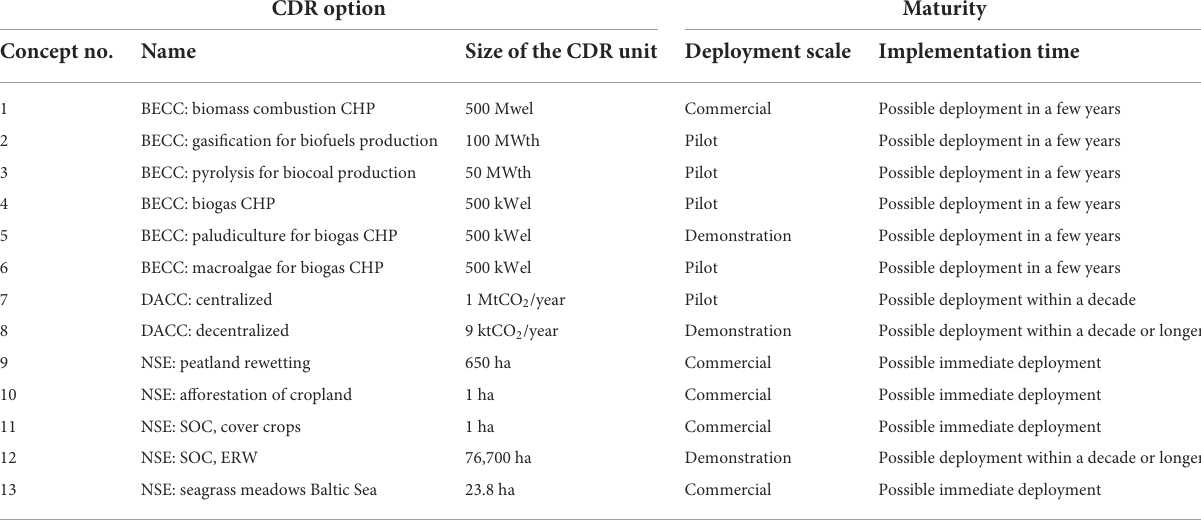
TABLE 2 Overview of the CDR concepts considered in the study with current scale and estimated time of deployment of CDR options. CDR option Maturity Concept